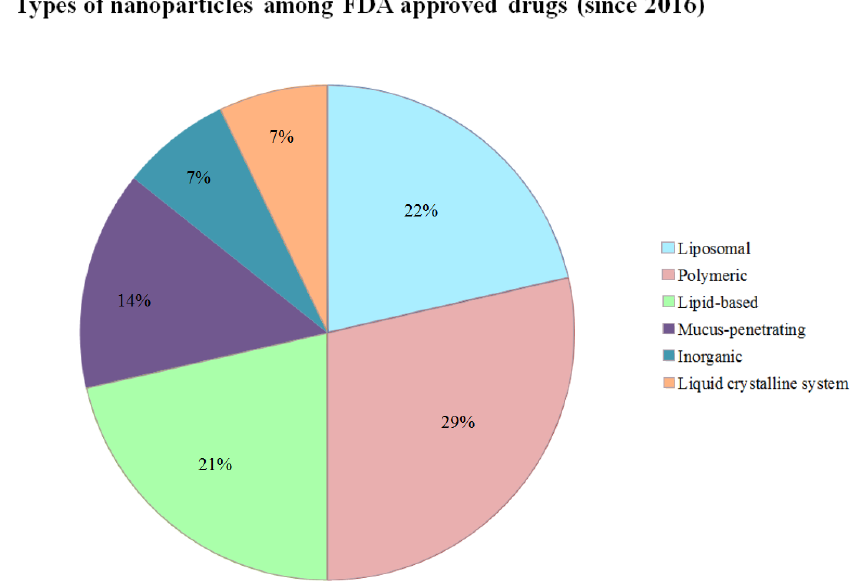
Figure 5. Common types of nanoparticles among FDA-approved drugs (since 2016). This figure depicts the types of nanoparticles that were used in FDA-approved medicine (since 2016). The most common were polymeric drugs (29%). The second most common were liposomal drugs (22%). However, lipid-based formulations appeared to be very close to liposomal drugs among FDA-approved medicine since 2016 (21%). Mucus-penetrating nanoparticles (14%) were applied primarily in ocular